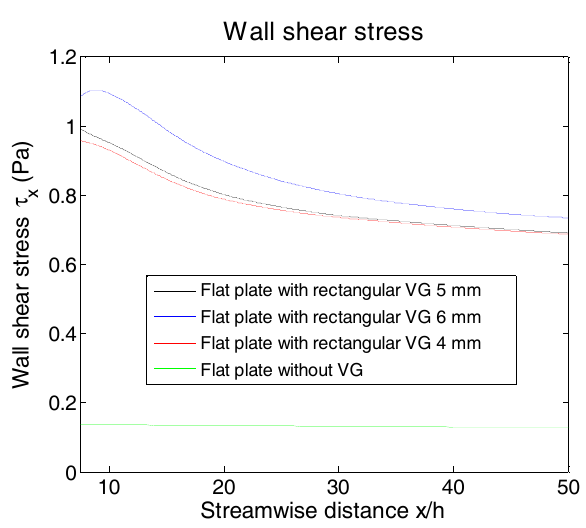
Figure 15. Wall shear stress comparison in the streamwise direction from the VG trailing-edge to 50H (spanwise distance z = 0) of the three different VG heights and without any vane on the wall.